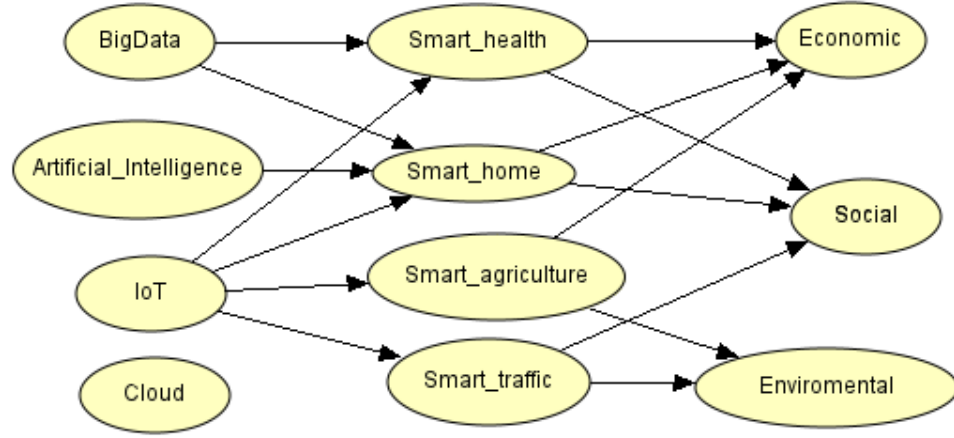
Figure 10. Probabilities of attack to smart city domains.